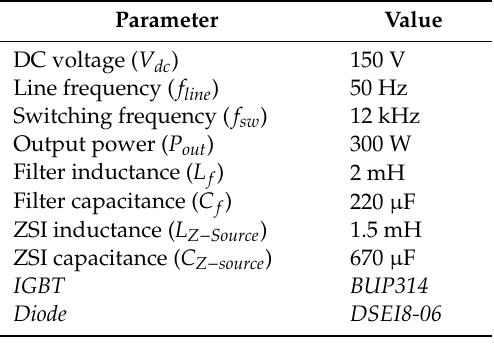
Table 5. Prototype Main Specifications.